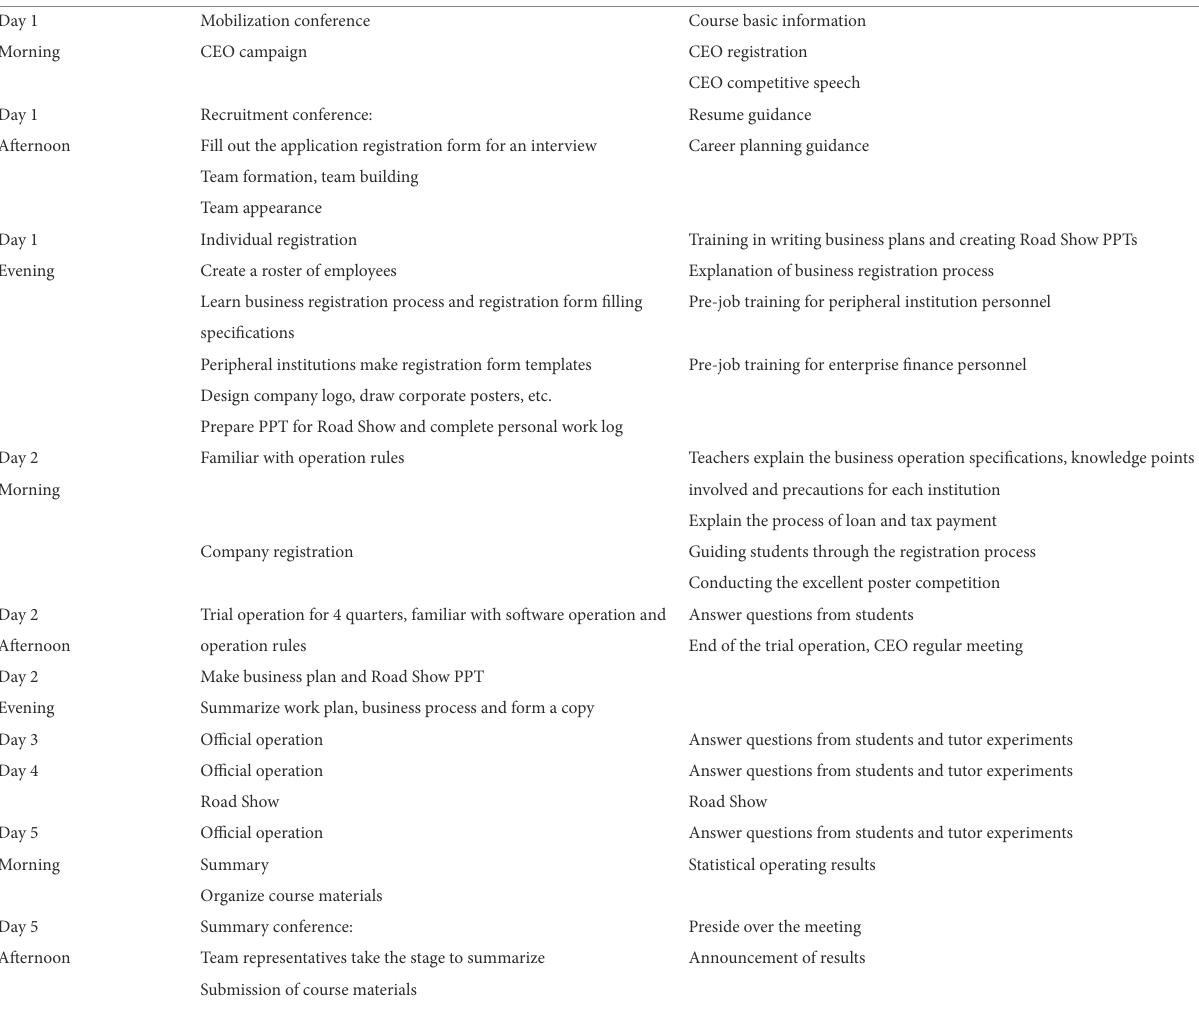
TABLE 1 Teaching schedule (condensed